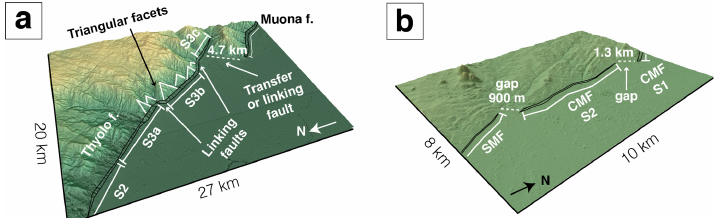
Figure 14. Oblique perspective images taken from the TanDEM-X DEM for sections of the (a) Thyolo and Muona faults and (b) Malombe fault scarps. (a) The secondary segments along TOFS3 of the Thyolo fault, showing the triangular facets synonymous with an mature scarp and the structure that connects the Thyolo and Muona faults. (b) The soft linkage between the central fault segments (CMAFS1 and CMAFS2) and between the central and southern faults; each are offset by around